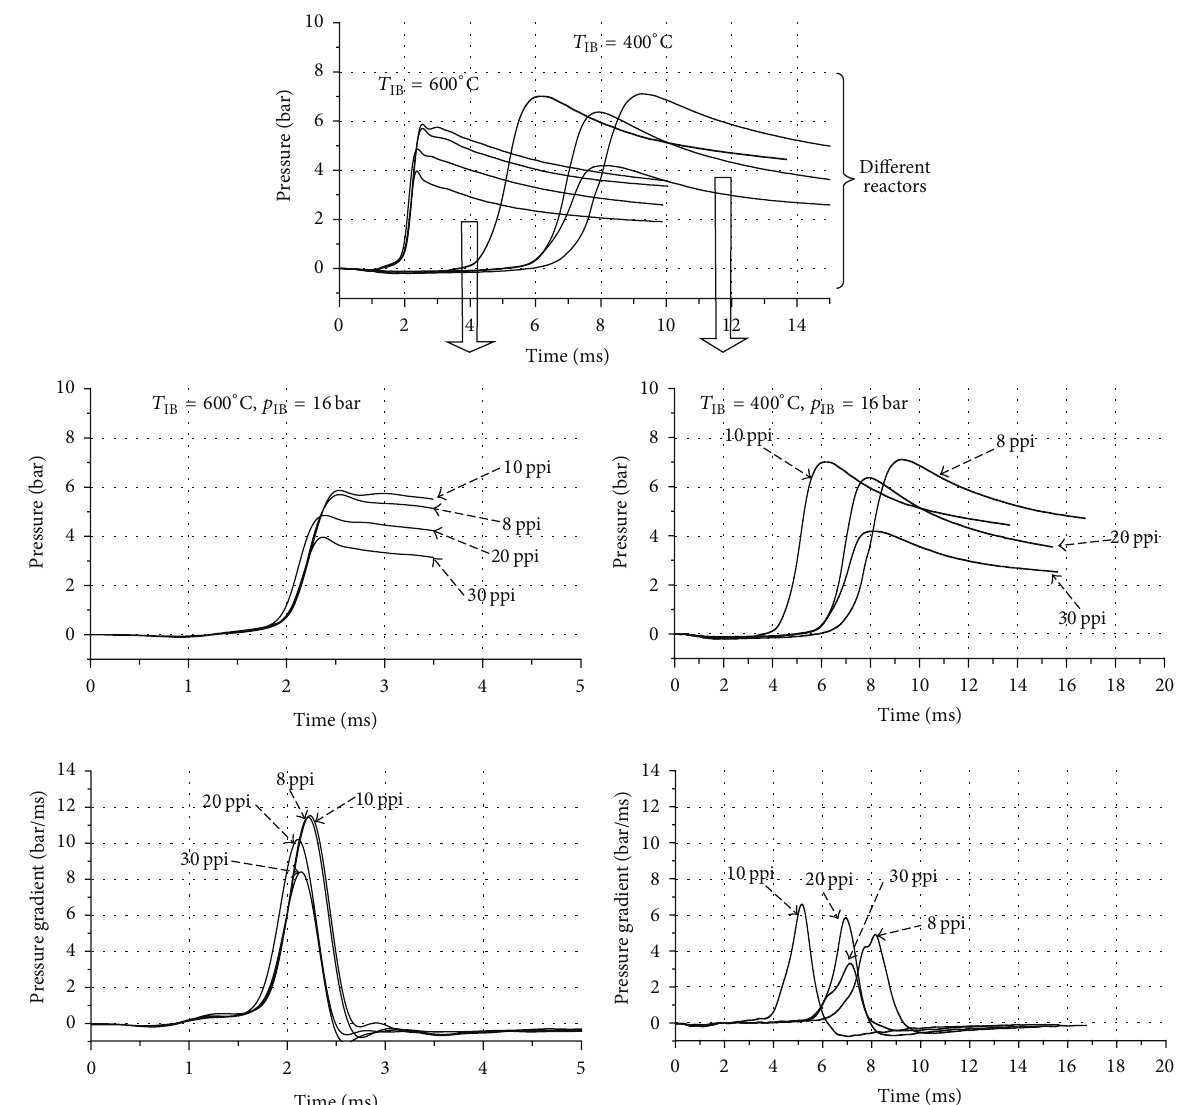
Figure 11: Comparison of pressure histories and pressure gradient distributions for heat release in different SiC foam porous reactors after fuel injection starts at two initial reactor temperatures 400 ∘ C (left) and 600 ∘ C (right) and for initial pressure 𝑝 injected fuel is 23.7